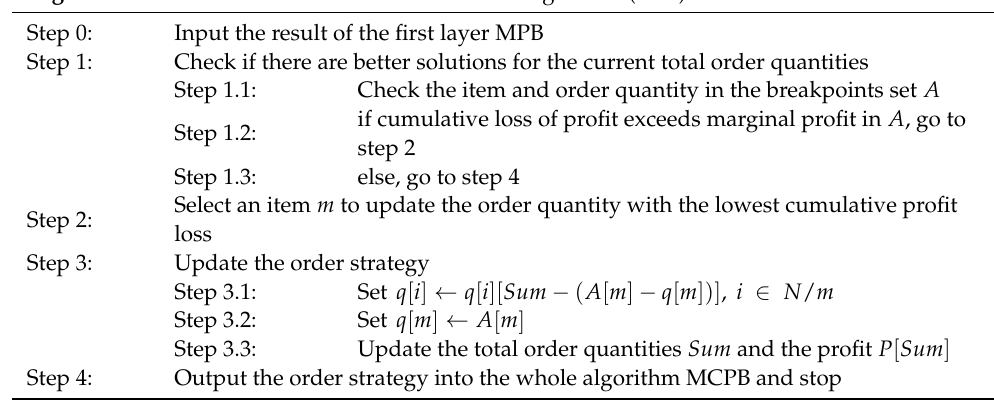
Algorithm 2. Process of Cumulative Profit-Based Algorithm (CPB).